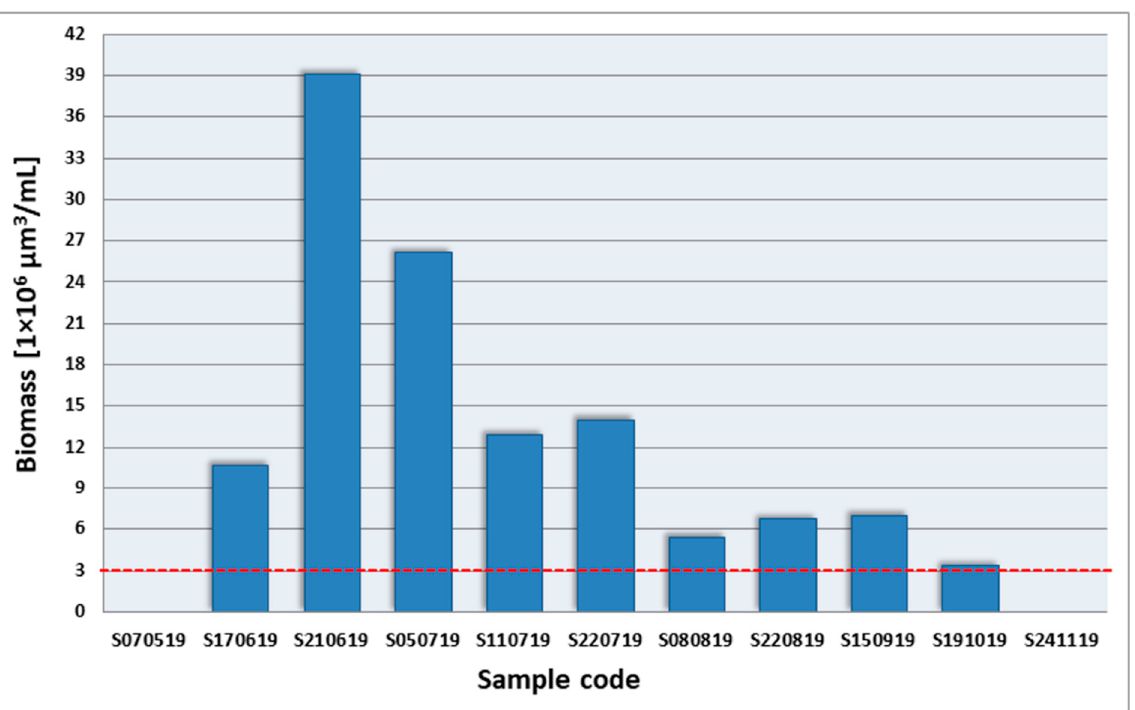
Figure 8. Total biomass of identified cyanobacteria taxa in the samples from Stryków artificial reservoir; red line is the threshold biomass value for bloom phenomenon.